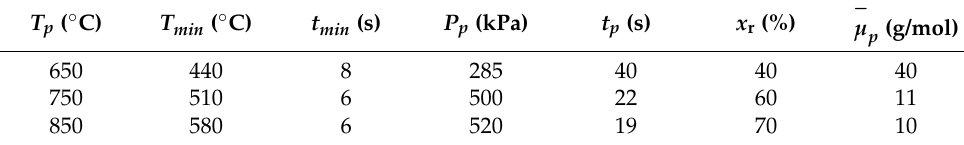
Table 2. Characteristics of the GG during pyrolysis of granular PE at m 0 = 1 g. T p ( ◦